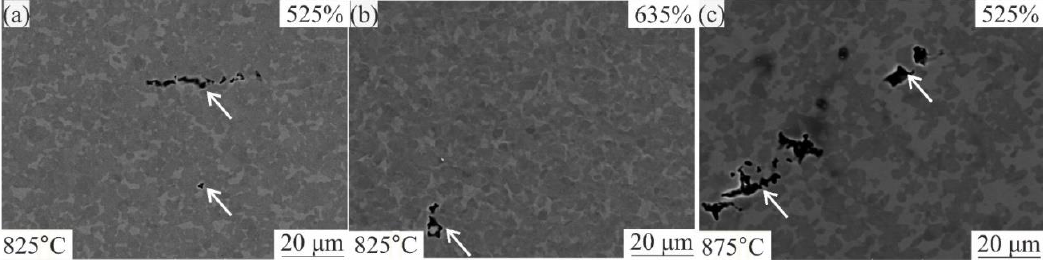
Figure 7. SEM microstructure of the investigated alloy at 1 × 10 -3 s −1 and temperature of ( a,b ) 825 °C and ( c ) 875 °C.